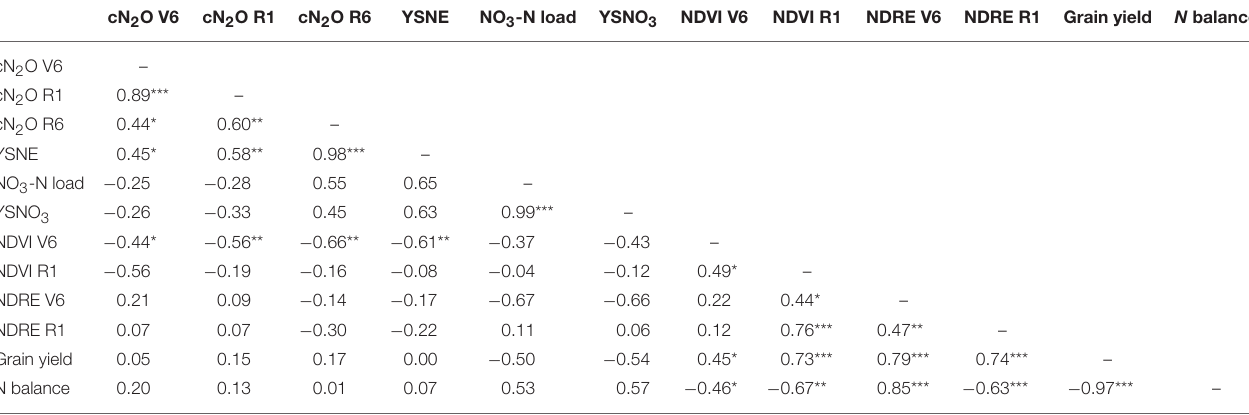
TABLE 1 | Pearson’s correlation coefficient of correlations analysis between remote sensing vegetation indices, crop, air, and water quality